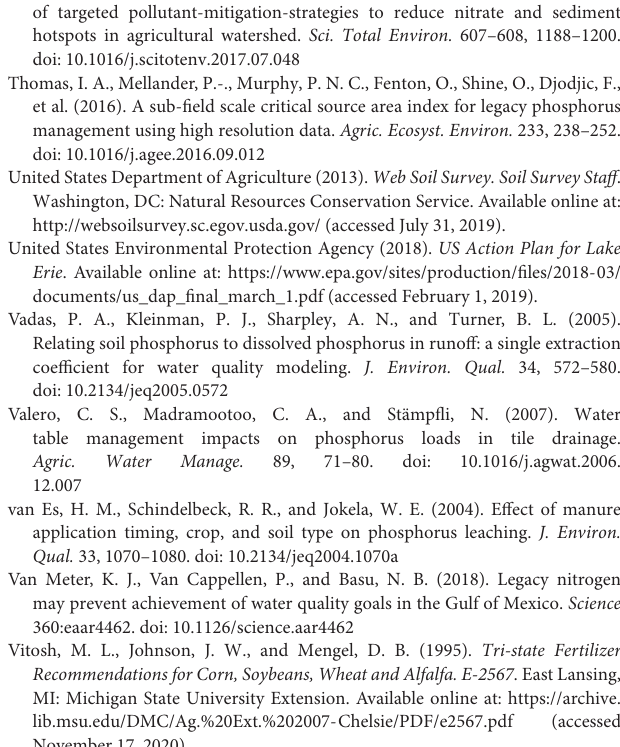
table management impacts on phosphorus loads in tile drainage.